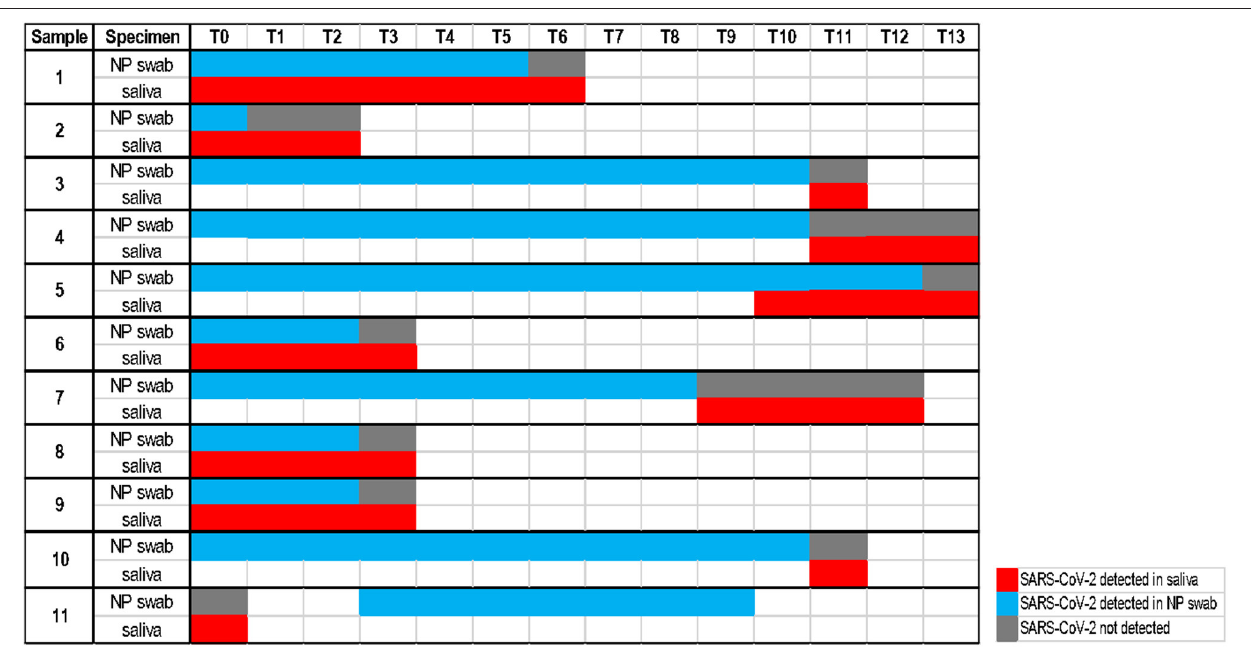
FIGURE 2 | Timeline with a follow-up analysis on 11 discordant cases (each time point considers an interval of one